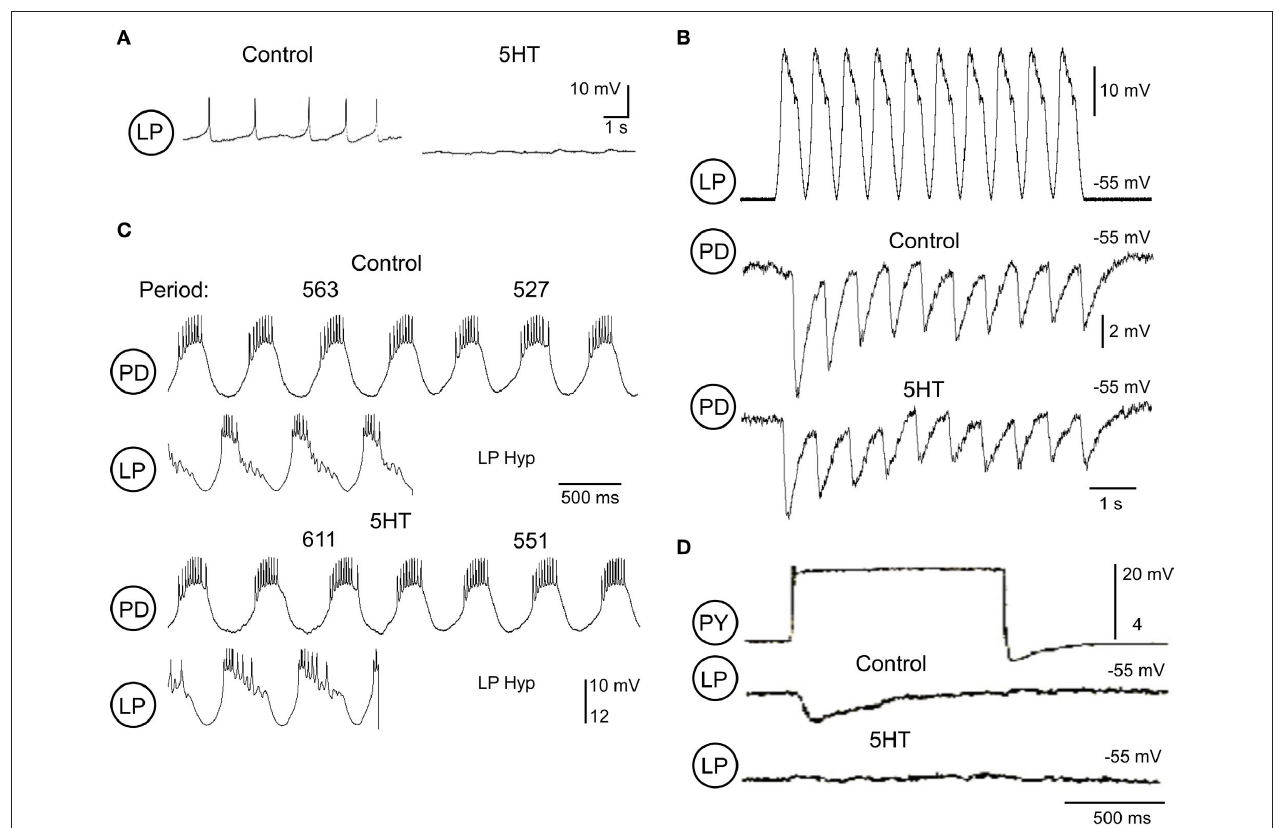
traces show examples of PD and LP activity before and after LP hyperpolarization (LP Hyp) under control conditions. Bottom traces show the same activity and responses during 5-HT application. Measurements of the cycle period before and after LP Hyp are given above the PD traces. (D) The PY graded inhibition of LP is greatly weakened during 5-HT application (modified from Johnson et al.,